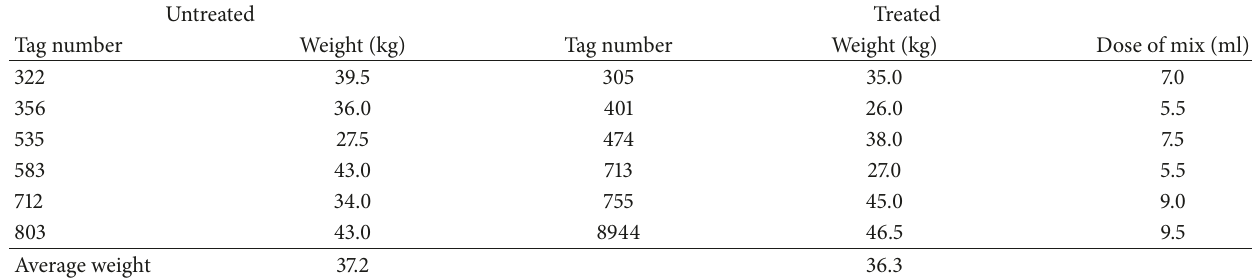
Table 1: Tag numbers and weights for weaner mixed sex red deer with the volume of Exodus Pour-On and Oxfen C Plus 50/50 mixture used per os for treated individuals.